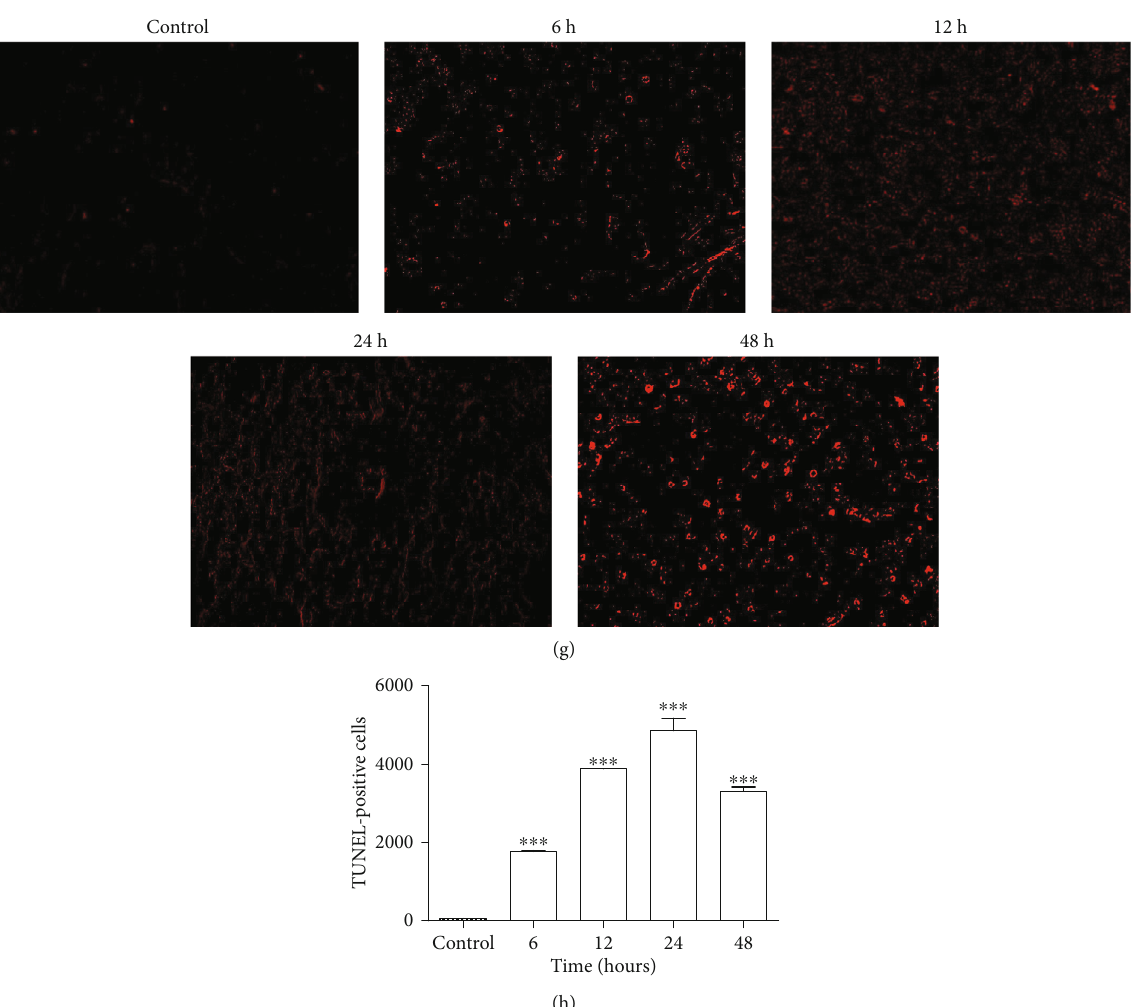
Figure 1: (a) E ff ect of short-term exposure of Tacrolimus on histopathological alterations in rat liver sections of control, 6, 12, 24, and 48h treatment groups. PAS-D staining of liver control group showing intact liver architecture with almost no globules, while treatment groups indicate derangement of hepatocytes and presence of globules (arrows) due to collagen digestion (400x). Scale bar used is 50 μ m. (b) E ff ect of short-term exposure of Tacrolimus on histopathological alterations in rat liver sections of control, 6, 12, 24, and 48h treatment groups. Reticulin staining of control group showing intact liver architecture with normal reticulin fi bers, while treatment groups indicate derangement of hepatocytes and collapsed reticulin network (black gray color) (400x). Scale bar used is 50 μ m. (c) E ff ect of short-term exposure of Tacrolimus on PCNA immunostaining in rat liver tissue sections of control, 6, 12, 24, and 48h treatment groups (400x). Scale bar used is 50 μ m. Degree of brown staining shows intensity of immune reaction. (d) IRS of PCNA in all experimental groups was scored and data was analysed using one-way ANOVA. Data is represented as mean ± SEM ( n = 3 ). ∗ P ≤ 0 : 05 , ∗∗ P ≤ 0 : 01 , and ∗∗∗ P ≤ 0 : 001 . (e) E ff ect of short-term exposure of Tacrolimus on CK-7 immunostaining in rat liver tissue sections of control, 6, 12, 24, and 48 h treatment groups (400x). Scale bar used is 50 μ m. Degree of brown staining shows intensity of immune reaction. (f) IRS of CK-7 in all experimental groups was scored and data was analysed using one-way ANOVA. Data is represented as mean ± SEM ( n = 3 ). ∗ P ≤ 0 : 05 , ∗∗ P ≤ 0 : 01 , ∗∗∗ P ≤ 0 : 001 . (g) E ff ect of short-term exposure of Tacrolimus on DNA damage in rat liver sections of control, 6, 12, 24, and 48 h treatment groups depicted by TUNEL assay staining (400x). Scale bar used is 50 μ m. (h) TUNEL-positive cells in all experimental groups were counted using ImageJ, and data was analysed using one-way ANOVA. Data is represented as mean ± SEM ( n = 3 ). ∗ P ≤ 0 : 05 , ∗∗ P ≤ 0 : 01 , and ∗∗∗ P ≤ 0 : 001